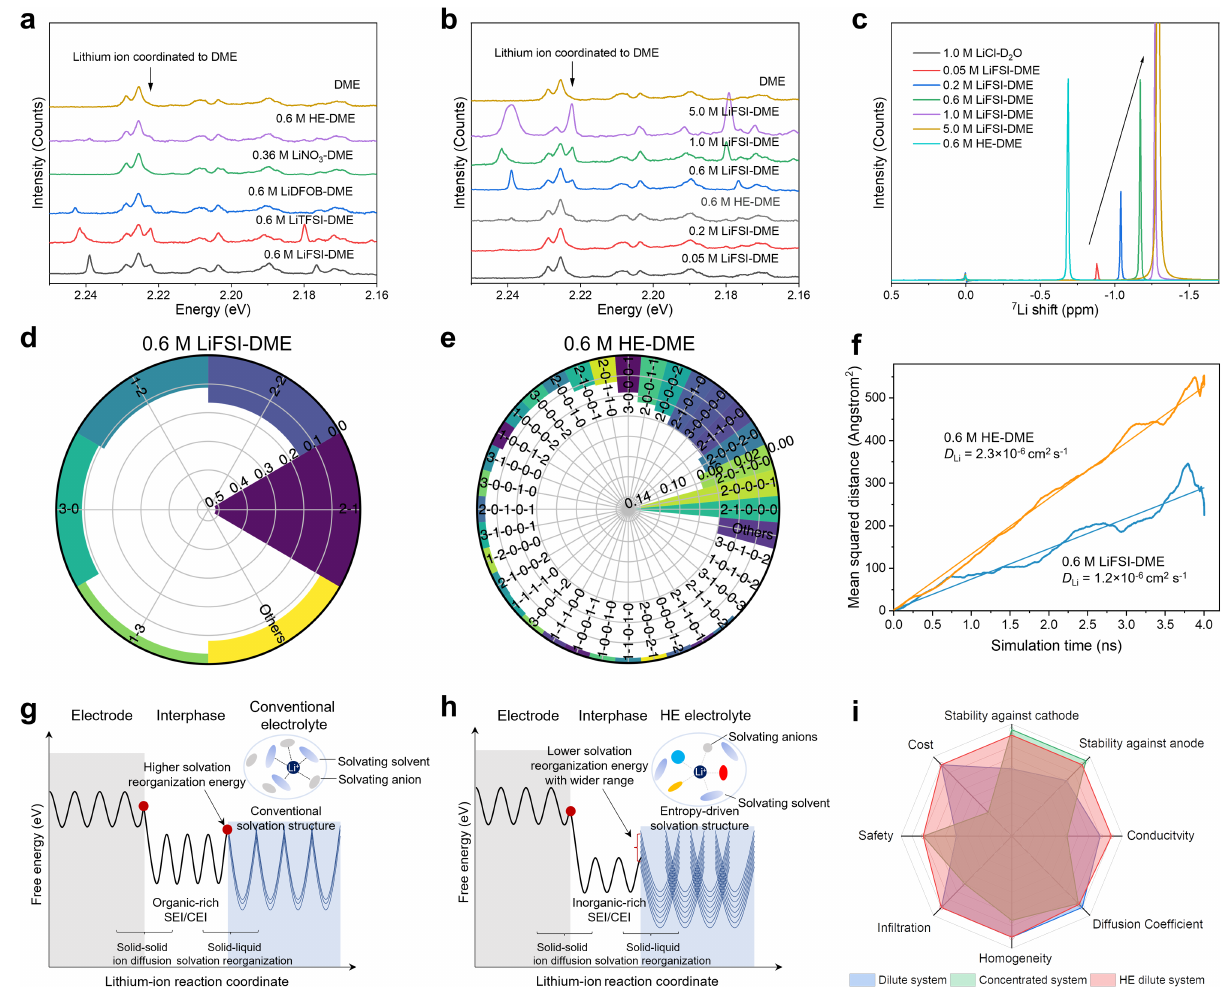
Fig. 5 | Solvation structure of HE electrolytes. a Raman spectra of the single salt and HE electrolytes. b Raman spectra of different LiFSI concentration DME electrolytes. c 7 Li NMR spectra of the HE-DME electrolyte and the LiFSI in DME electrolytes, referenced to a 1M LiCl in D 2 O solution. Lithium-ion coordination environments of d the 0.6M LiFSI-DME electrolyte and of e the 0.6M HE-DME electrolyte determined from MD simulations (detailed description in the